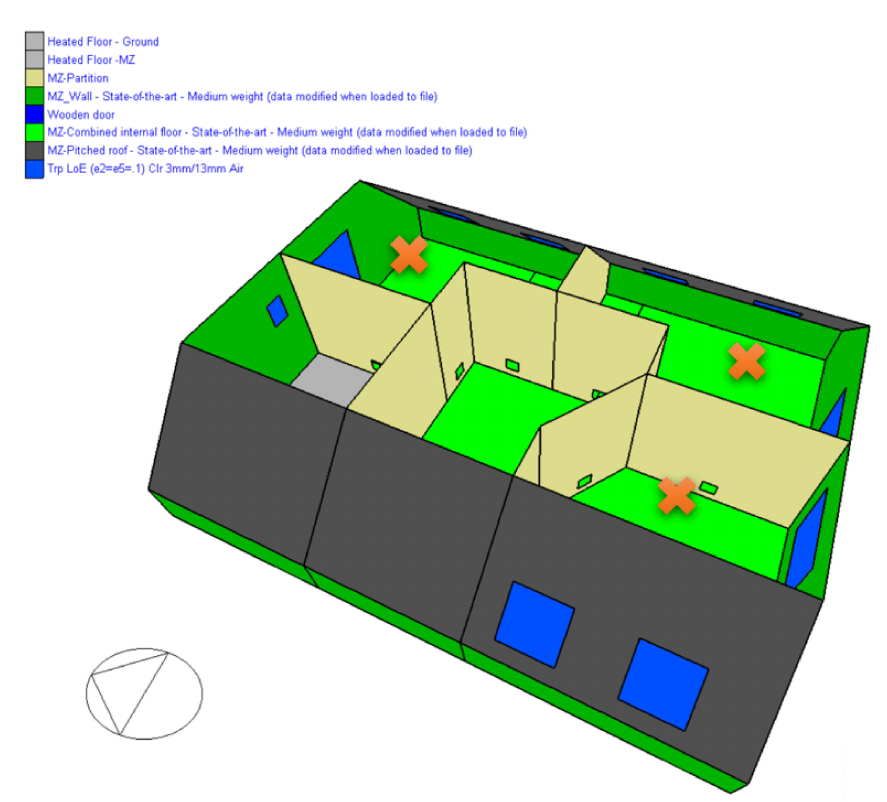
Figure 5. Model of dividing the first floor into